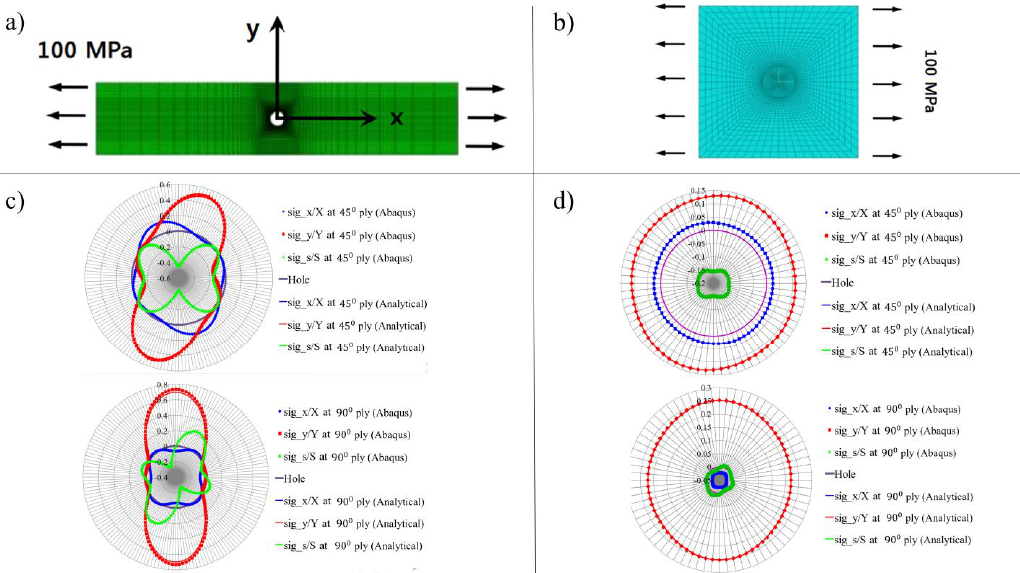
Figure 2. Validation of proposed analytical model with finite element model : ( a ) FEM model of open-hole laminate ( b ) FEM model of filled-hole laminate ( c ) Stress to strength ratio comparison of 45° and 90° plies in open-hole laminate ( d ) Stress to strength ratio comparison of 45 ° and 90 ° plies in filled-hole laminate.